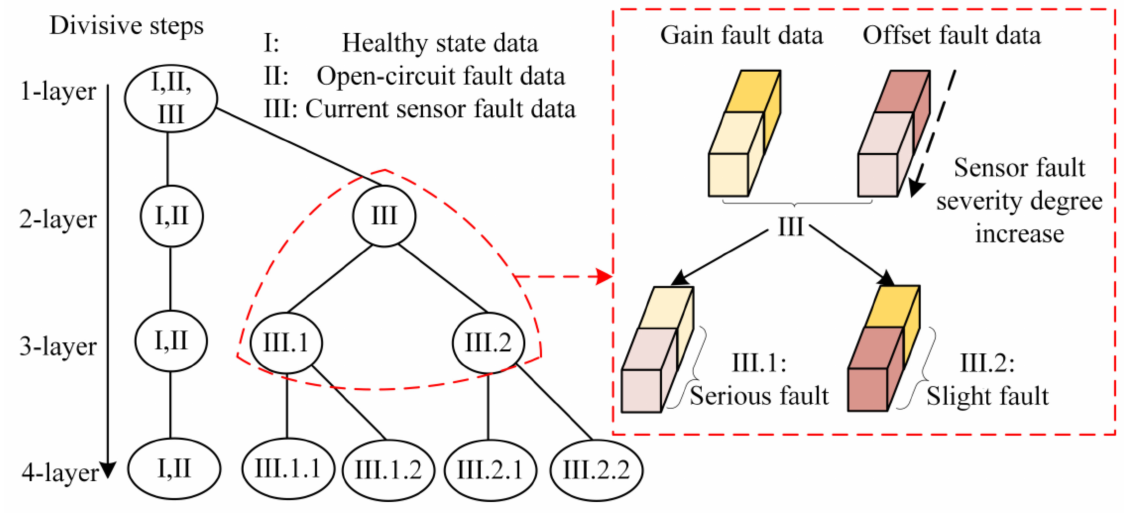
Figure 4. Schematic diagram of the historical fault data